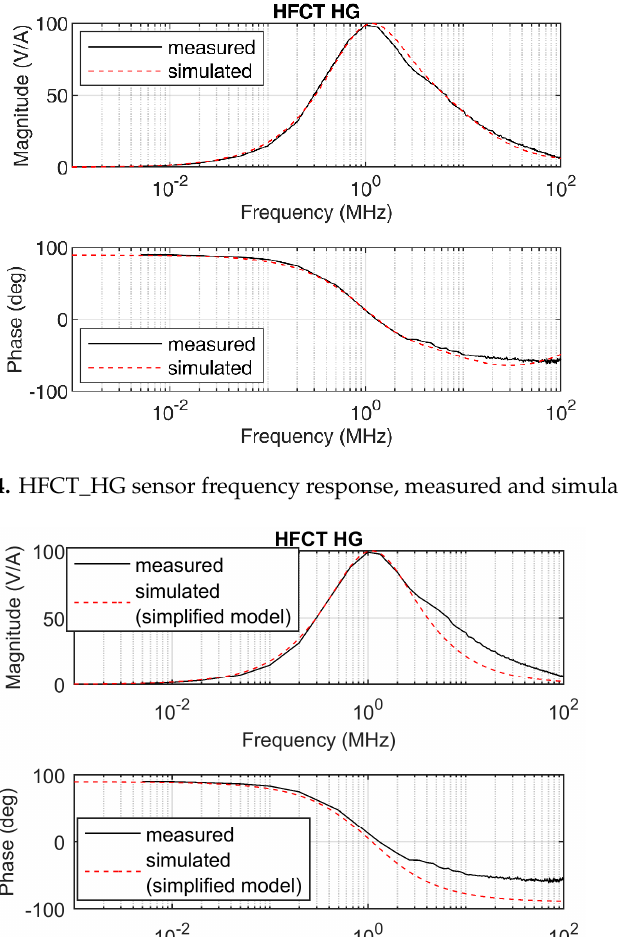
4 of 16 Figure 3. HFCT_LG sensor frequency response, measured and simulated. 2.2. Generic HFCT Model In some situations, the frequency response of a sensor based on magnetically coupled inductors cannot be represented by the simplified model, particularly when the sensor does not exhibit a flat and wide frequency response. The deviations from the simplified model are due to different aspects not taken into account in the simplified model. Some of them are the permeability frequency dependence behavior, the non-linear losses in the magnetic core, the multiple coil resonances or, for instance, the effect of parasitic capacitances. To illustrate this fact, another sensor has been built using different resistor values while using the same magnetic core material and number of turns in the secondary coil as the previous sensor. Table 2 shows the parameters of the sensor named HFCT_HG. Table 2. HFCT_HG sensor parameters. Sensor